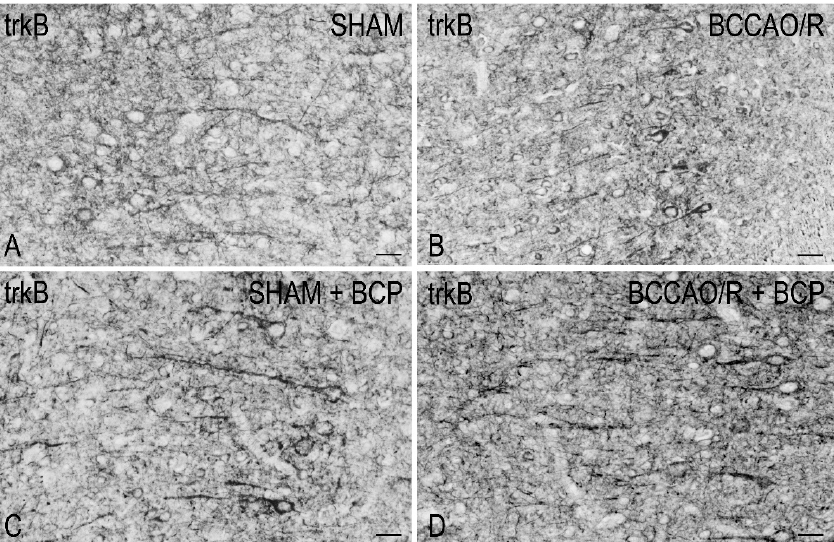
Figure 5. Tyrosine kinase receptor B (trkB)-like immunoreactivity in coronal sections of frontal cortex of sham-operated and bilateral common carotid artery occlusion followed by reperfusion (BCCAO/R) rats pre-treated with either the vehicle alone ( A , C ) or with resveratrol (BCP) ( B , D ). Positive neuronal processes, punctate elements, and neuronal perikarya are distributed across the whole thickness of the cortex. Arrows point to immunostained neuronal perikarya. Panels are representative of observations carried out in 6 rats for each group. Scale bars: 25 μ m.